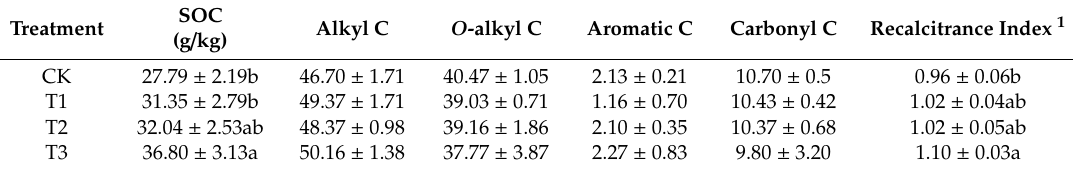
Table 1. Soil organic carbon (SOC) concentration, the integrated intensities (%) of major 13 C cross-polarization magic-angle-spinning (CPMAS) NMR spectral region and recalcitrance index under the simulated acid rain (SAR) treatment in the 0–10 cm soil